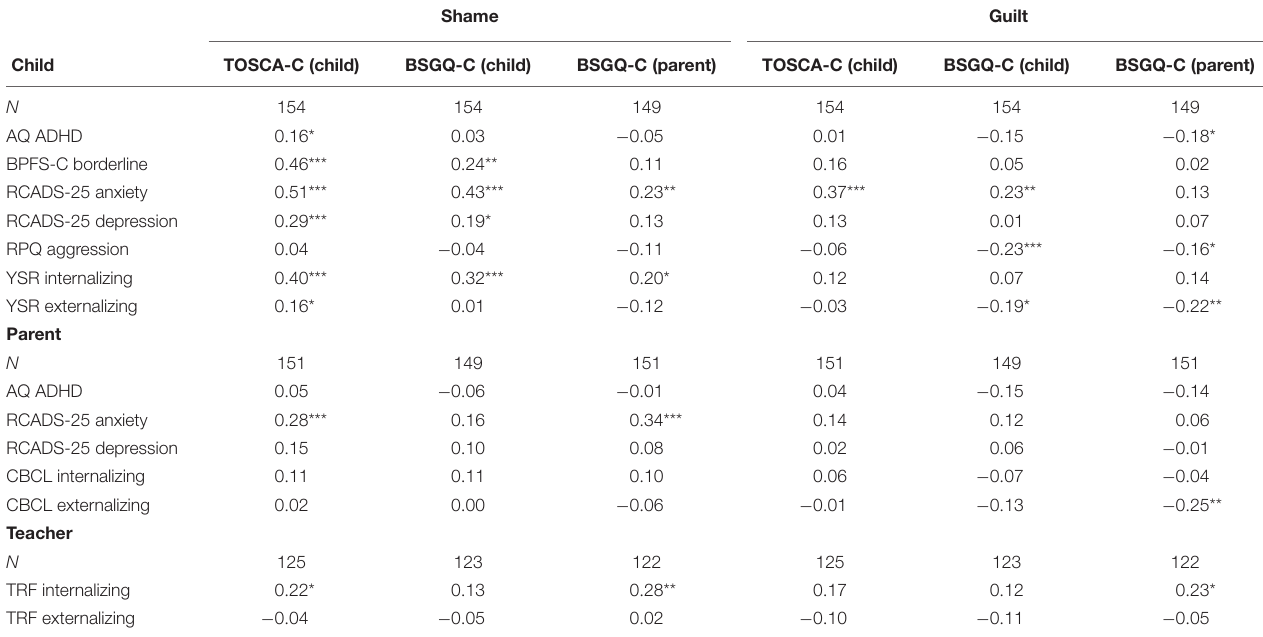
TABLE 3 | Correlations (controlled for gender and age) between the child- and parent-report scales measuring the self-conscious emotions of shame and guilt and various indices of psychopathology as completed by the children (upper panel), parents (middle panel), and teachers (lower panel). Shame